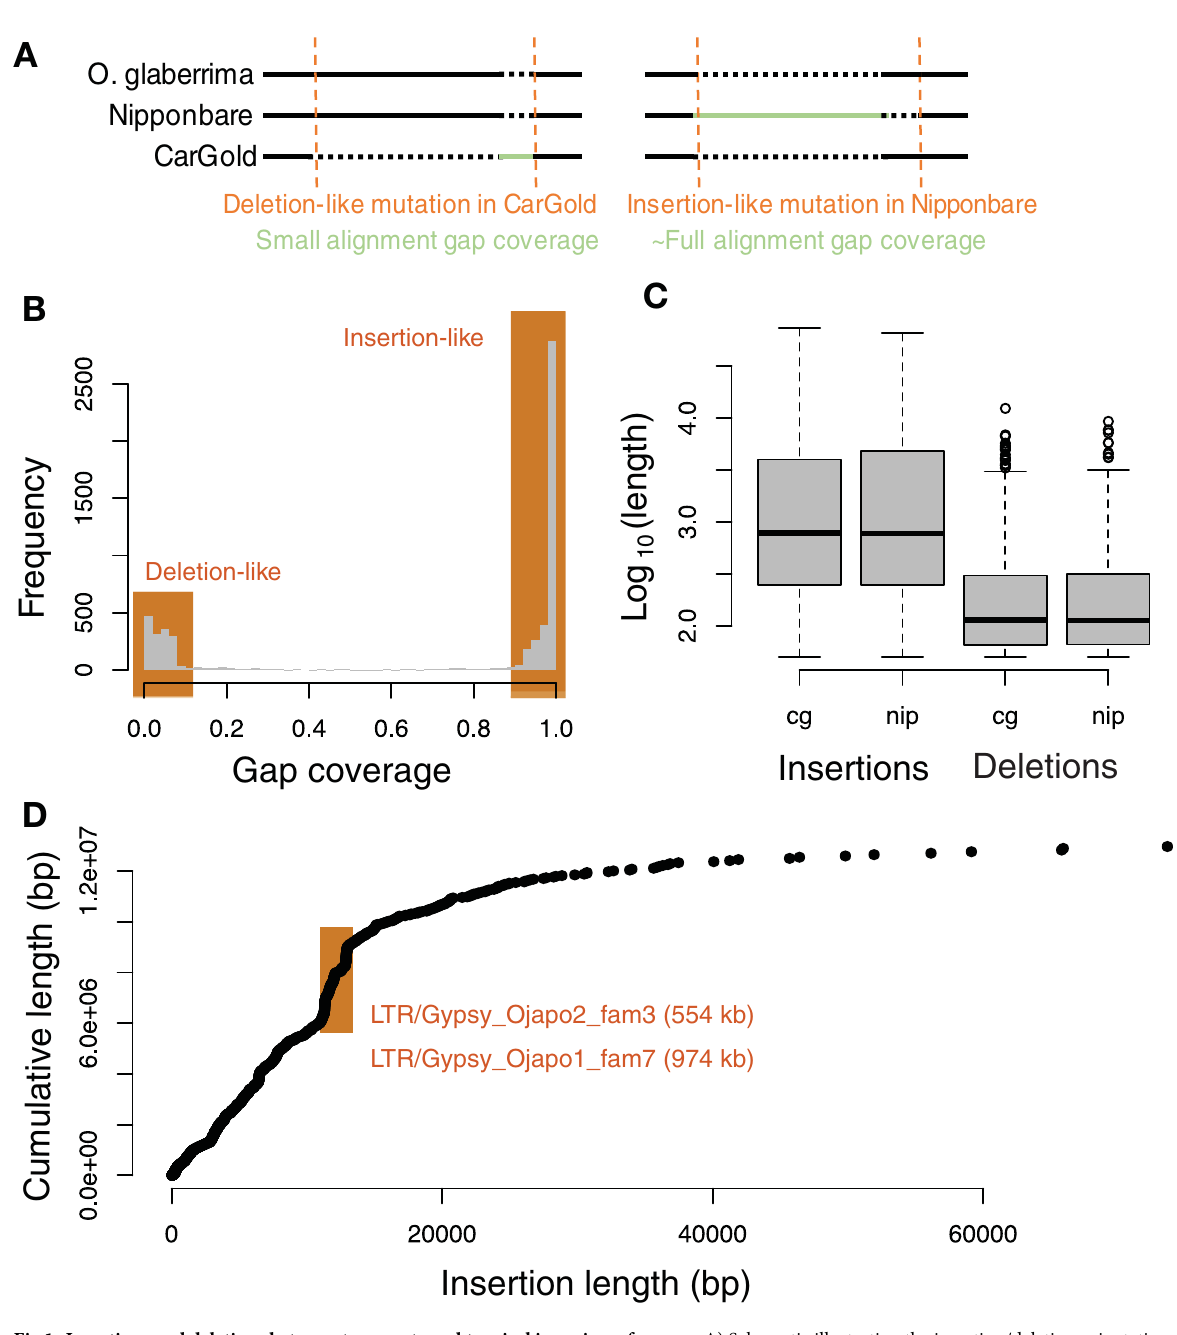
Fig 1. Insertions and deletions between temperate and tropical japonica references. A) Schematic illustrating the insertion/deletion orientation method for indel characterization. Any mutation found only in O . glaberrima is ambiguous and ignored. B) Distribution of gap coverage values across all events analyzed. As indicated, insertions and deletions are defined as mutations with a gap coverage of > 95% or < 5%, respectively. C) Boxplot depicting the log-transformed size distribution of events broken out by type and the variety–CarGold (cg) or Nipponbare (nip)–in which it was derived. D) Scatterplot showing each insertion, sorted by length, and its impact on cumulative length of all insertions. TEs contributing to rapid changes in total inserted sequence are indicated by orange